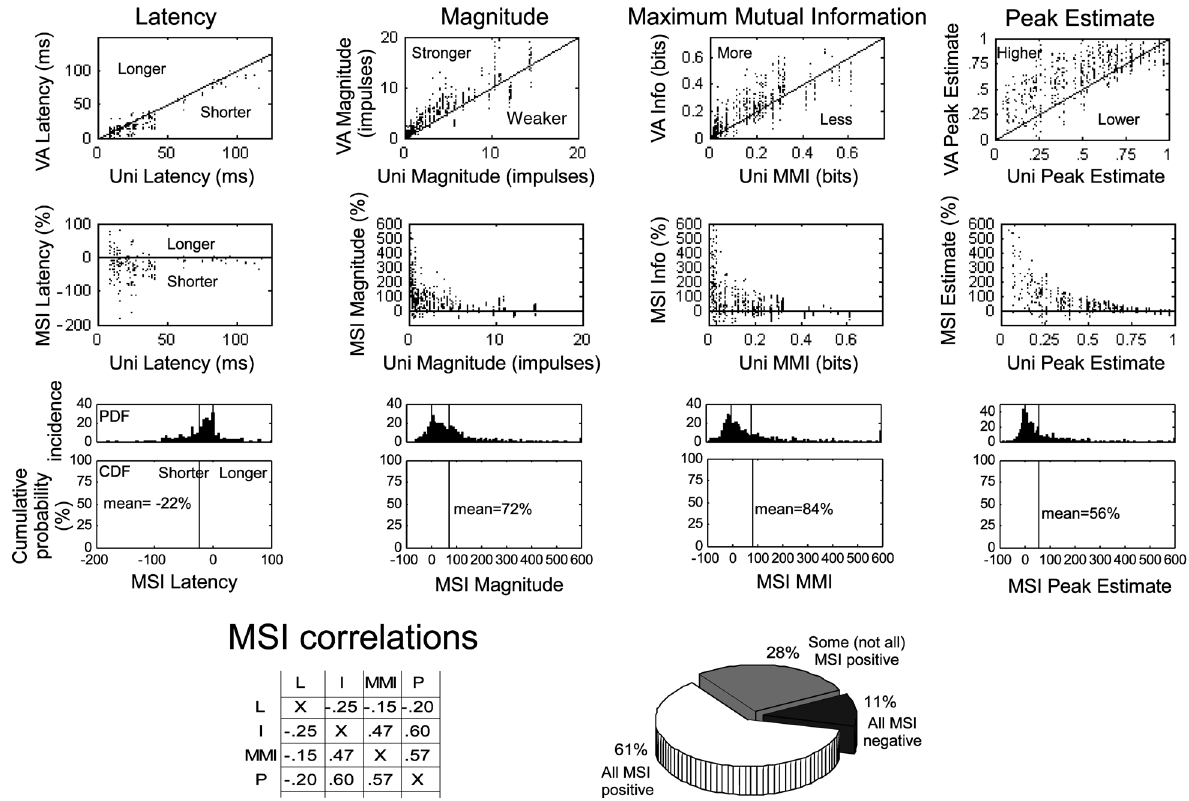
Figure 3. Measures of multisensory enhancement over the entire response . The four columns of graphs at the top profile the multisensory enhancements observed in different measures of the neural response: latency, response magnitude, MMI, and peak event estimate. The first row of graphs compares the multisensory (VA) response to the best (i.e., fastest, largest) unisensory (V or A) response value for each variable. The solid black line gives the line of unity: points falling below unity in the latency graph indicate a shorter (i.e., enhanced) multisensory latency, points falling above unity indicate enhanced multisensory responses in all other cases. The second row of graphs compares the MSI (% difference between multisensory and best unisensory response) for each measure to the best unisensory response. Gray shaded regions track the envelope of these relationships. The third row of graphs provides the probability distributions and cumulative probability distributions of MSI for each of the measures. Dotted lines identify mean values. The bottom left of the figure provides the cross-correlation between the MSI calculated using the different measures (conventions the same as Figure2 ). The pie chart at the bottom right indicates how often the measures of response magnitude, MMI, and peak event estimate covary in the positive (61%) and negative (11%)